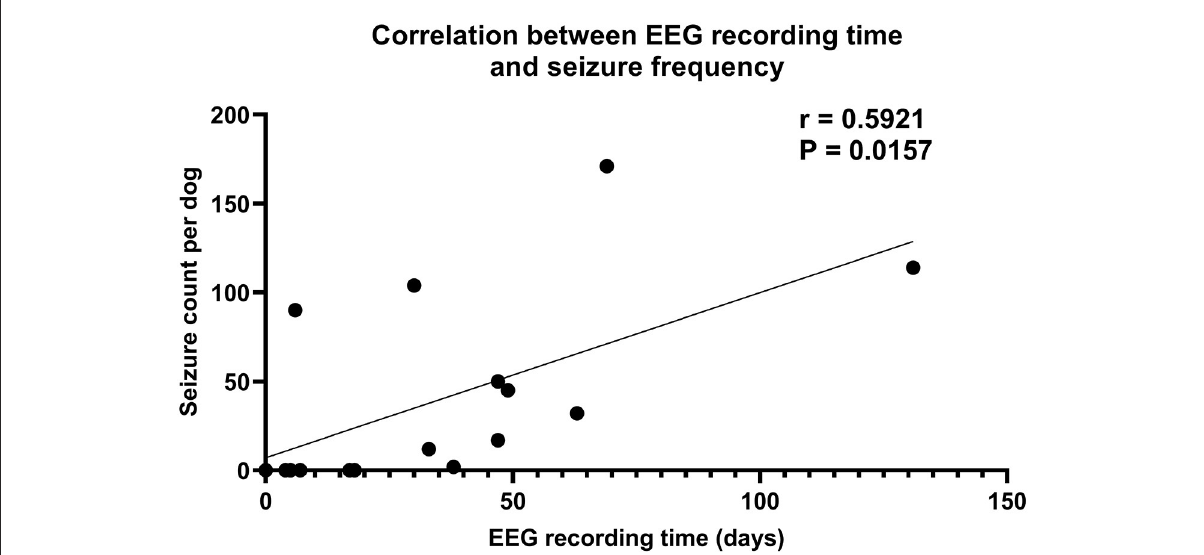
FIGURE4 Correlation between intracranial EEG (iEEG) recording time and seizure frequency in 16 dogs with naturally occurring epilepsy. For continuous (24/7) ambulatory iEEG recordings, either the NeuroVista Seizure Advisory System (SAS) or the Medtronic Summit System RC + S were used. The data show that the longer the recording time, the higher the chance of detecting spontaneous seizures in epileptic dogs. Data are from Gregg et al.